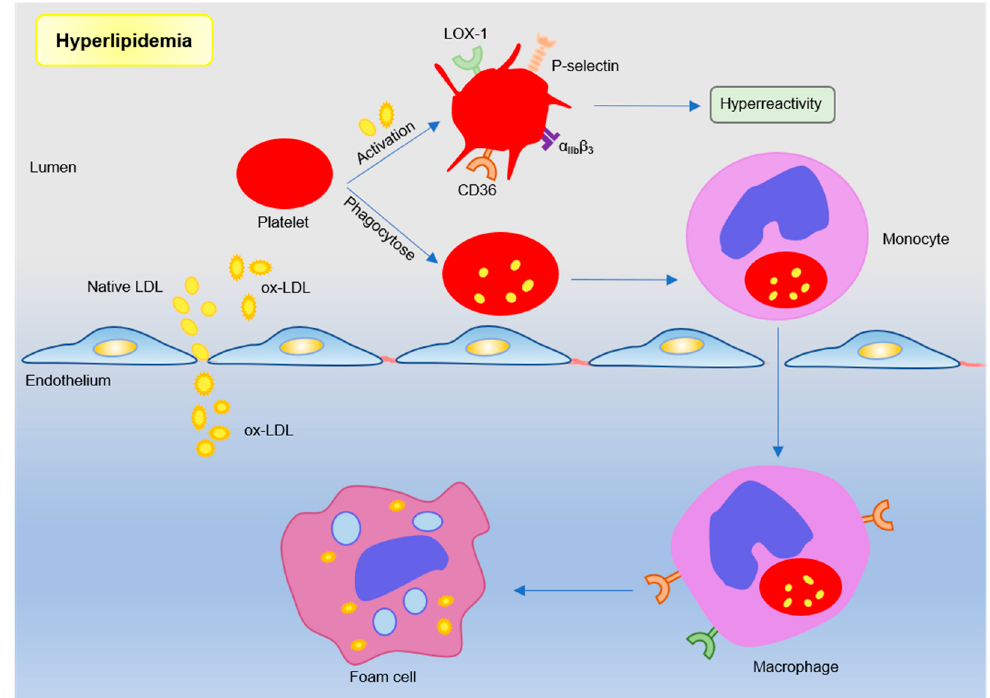
Figure 2. Platelets participate in atherosclerosis under hyperlipidemic conditions. Lipoproteins, such as low-density lipoproteins in plasma, trigger platelet activation by binding sites. Or monocytes engulf low-density lipoprotein (LDL)-containing apoptotic platelets and migrate under the inner membrane to di ff erentiate into macrophages and foam cells. Subendothelial oxidized LDL further participates in atherosclerotic plaque formation by binding to scavenger receptor CD36 and